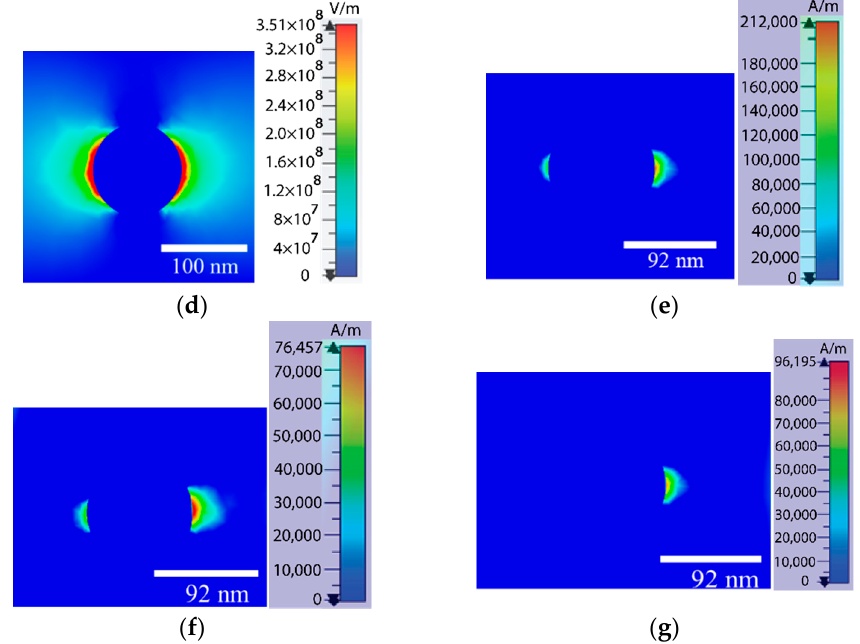
Figure 4. Electric ( E x ) and magnetic ( H y ) fi eld distributions outside the nanodisks with radii R 1 = 50 nm and R 2 = 46 nm. ( a ) Absorption spectra of nanoantenna with radius R 2 = 46 nm. ( b ) E x at λ = 900 nm, z = 240 nm, in element #2. ( c ) E x at λ = 883 nm , z = 240 nm, in element #1. ( d ) E x at λ = 889 nm, z = 240 nm, in element #1 . ( e ) H y at λ = 889 nm , z = 240 nm, in element #2. ( f ) H y at λ = 900 nm , z = 240 nm, in element #2. ( g ) H y at λ = 883 nm , z = 240 nm, in element #2.